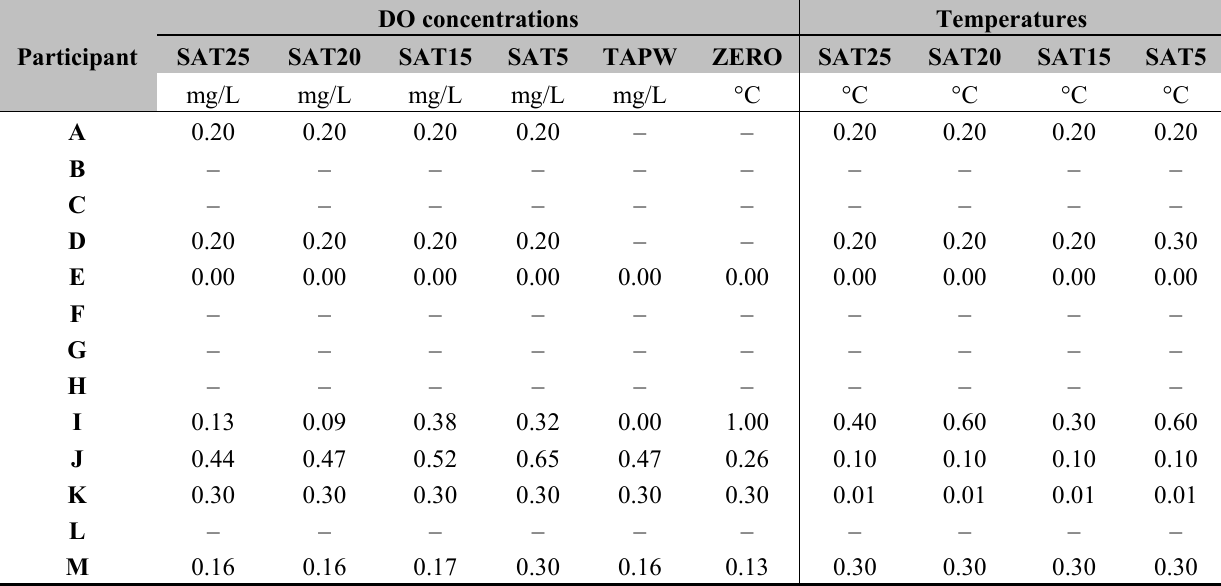
Table 5. The self-declared expanded uncertainties a of the participant values.